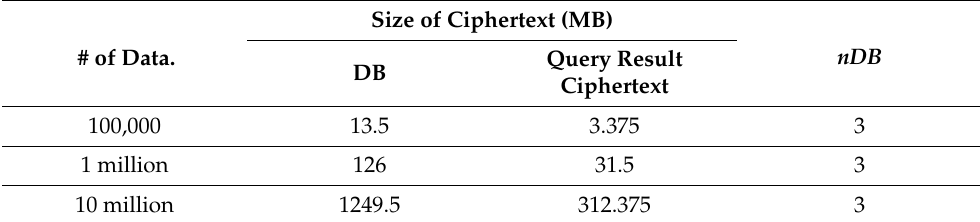
Table 5. Ciphertext size of the proposed scheme on the best parameter value. Size of Ciphertext # of Data.